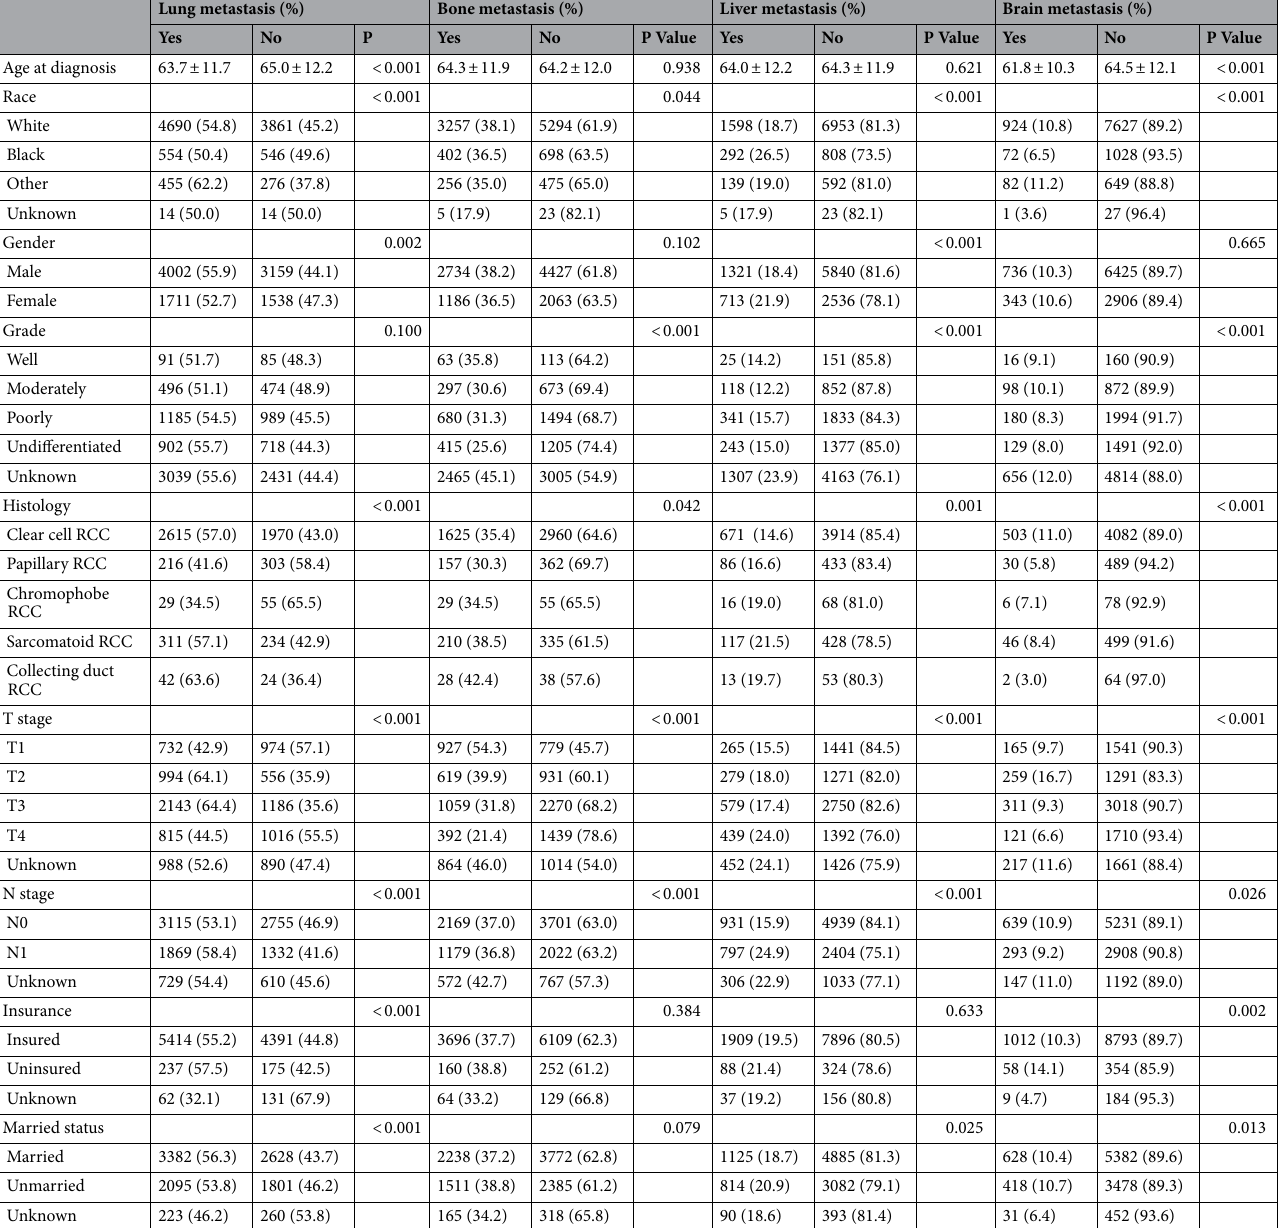
Table 1. Clinical features and metastasis sites for RCC. RCC renal cell